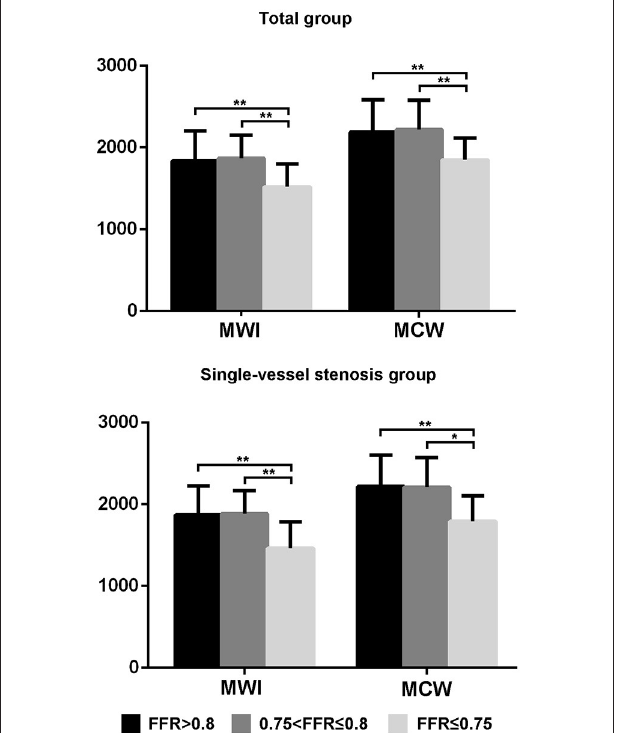
FIGURE 2 | The MWI and MCW values of left ventricular segments with FFR ≤ 0.75, 0.76–0.80, and > 0.80 in the total-vessel group and single-vessel stenosis subgroup. The MWI and MCW values for segments with FFR ≤ 0.75 were significantly lower compared to those with FFR 0.76–0.80, and FFR > 0.80. * p < 0.05, ** p < 0.01. FFR, fractional flow reserve; MCW, myocardial constructive work; MWI, myocardial work index.